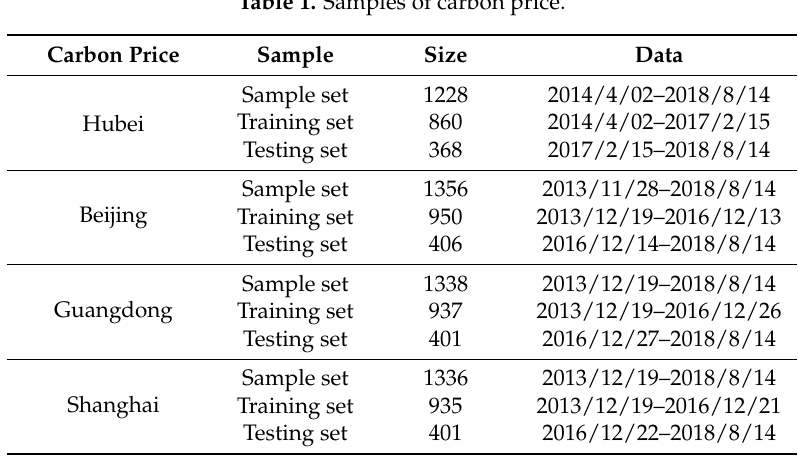
Figure 4. The carbon price fluctuations. Table 1. Samples of carbon